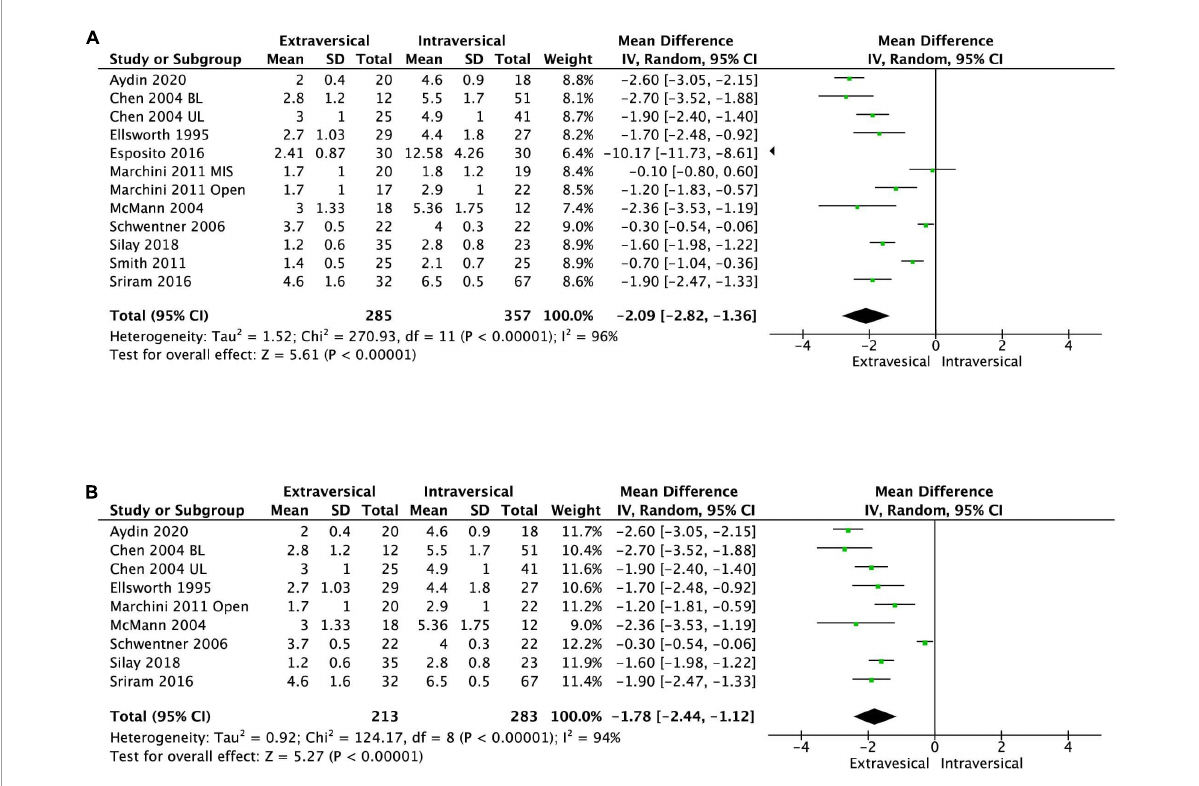
FIGURE8 Forest plot of length of stay after (A) EVUR vs. IVUR for VUR in general and (B) open EVUR vs. open IVUR.